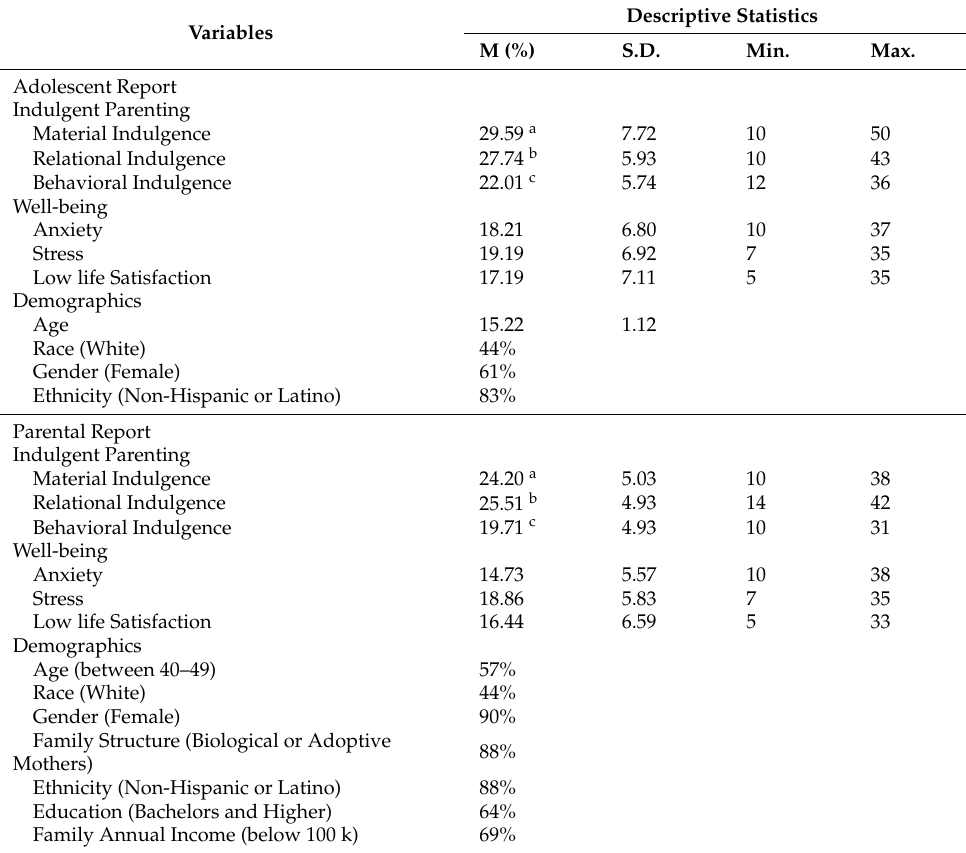
Table 1. Descriptive and demographic information on the study